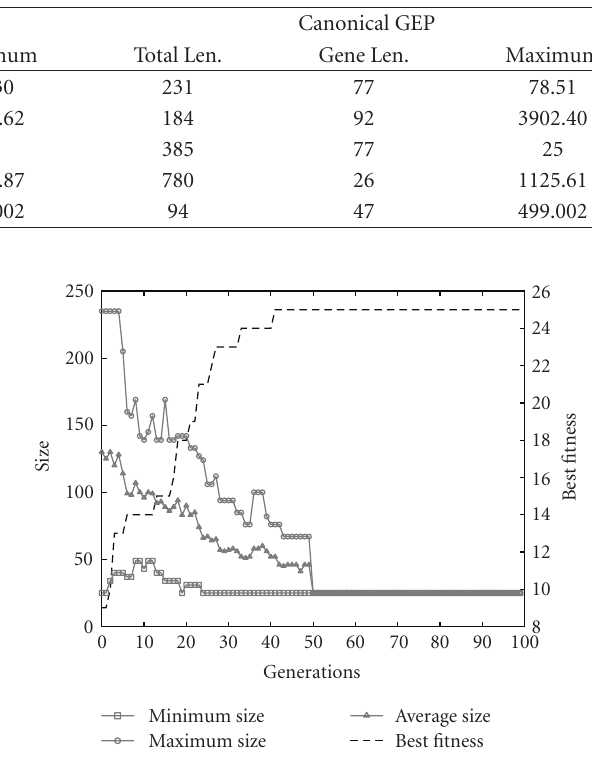
Figure 17: Parameter optimization Experiment 3: chromosome sizes and best fitness.